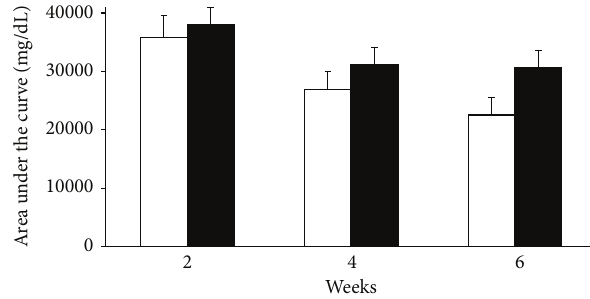
Figure 3: The area under the curve (AUC) of the intraperitoneal glucose tolerance test (IPGTT) at 2, 4, and 6 weeks in islet recipients with (black column) and without (white column) MK- 0431